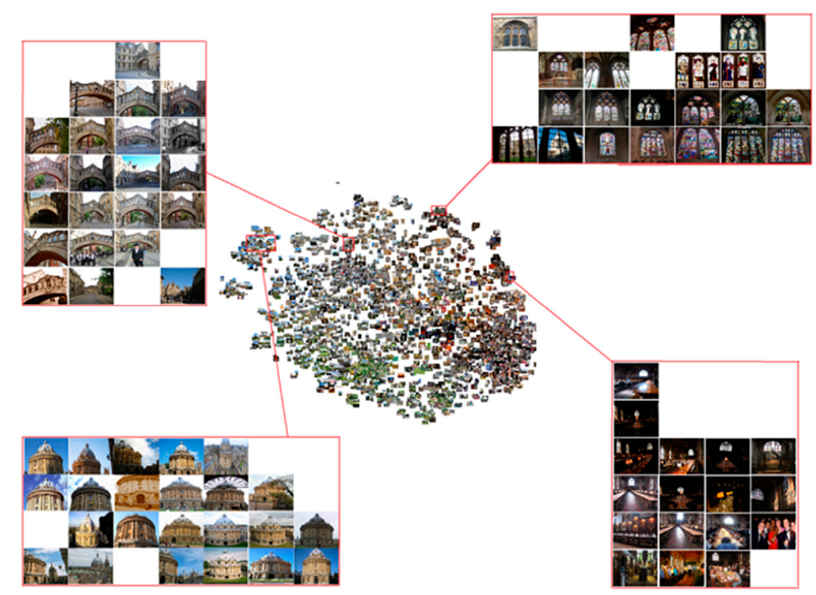
Figure 8. Barnes–Hut t-SNE (t-distributed stochastic neighbor embedding) [41] visualization of the learned embedding feature 𝐺𝑠𝑤 on the oxford5k data set [33].